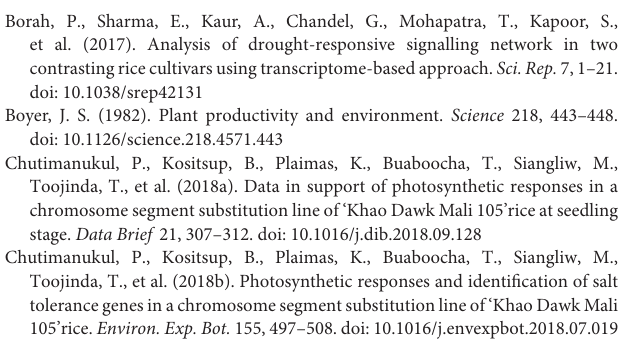
Supplementary Figure 1 | The gene set enrichment analysis of differentially expressed genes in seedlings when compared between the transcriptome of seedlings grown under normal (0 day) condition and after 75mM NaCl treatment for 2 days in term of biological process by using ClueGO tool. Supplementary Figure 2 | The gene set enrichment analysis for biological process of differentially expressed genes when compared between the transcriptome of second leaves from rice plants grown under normal (0 day) condition and after 75mM NaCl treatment for 3 days at booting stage with ClueGO tool. Supplementary Figure 3 | The gene set enrichment analysis for biological process of differentially expressed genes when compared between the transcriptome of flag leaves from rice plants grown under normal (0 day) condition and after 75mM NaCl treatment for 3 days at booting stage with ClueGO tool. Supplementary Figure 4 | The putative regulatory element analysis of OsBTBZ1 gene from CSSL16 and KDML105. Supplementary File 2 | The number of differentially expressed genes in leaves at seedling stage, second leaf, and flag leaf at booting stage under salt stress condition. Supplementary File 3 | List of significant candidate genes identified by gene co-expression network, clustering co-efficient and weighted